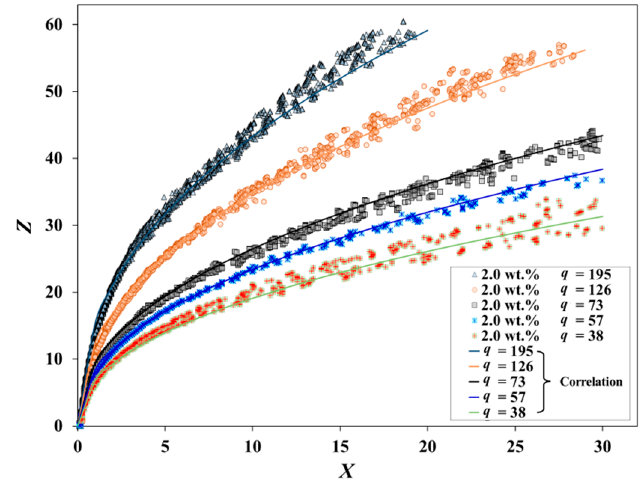
Figure 12. Jet trajectories at different q values.